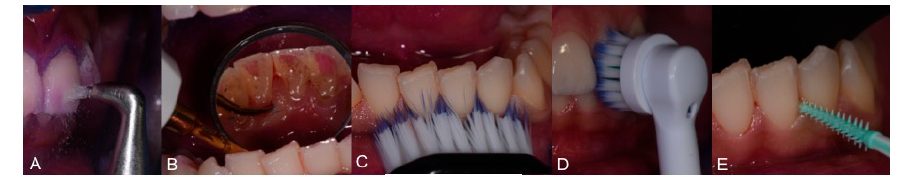
Figure 17. TBM protocol clinical steps: ( A ). Deplaquing; ( B ). scaling; ( C , D ). brushing; ( E ). interden- tal